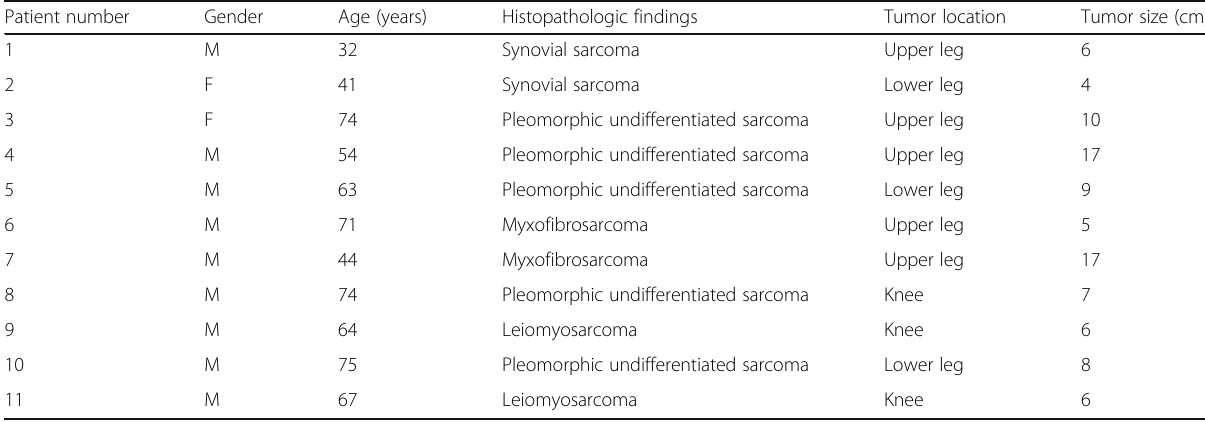
Table 1 Patient and tumor